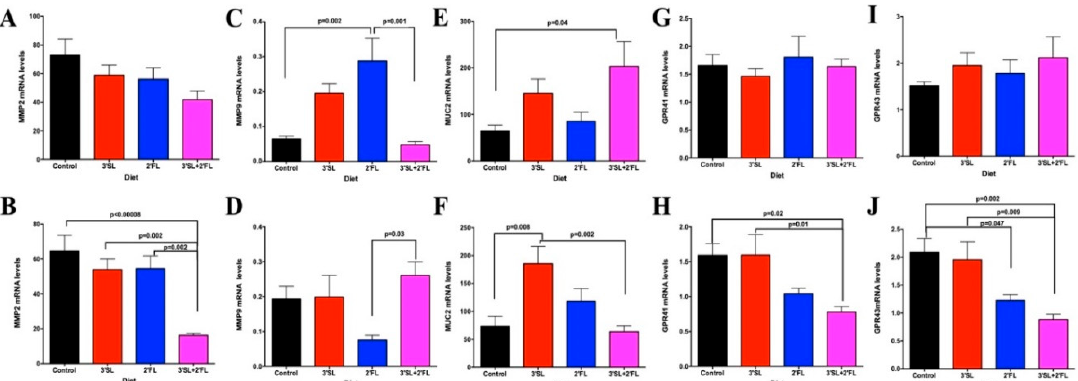
Figure 4. Proximal colon messenger RNA (mRNA) levels of ( A ) matrix metalloproteinase 2 (MMP2), ( C ) MMP9, ( E ) mucin 2 (MUC2) ( G ) G-protein-coupled receptor 41 (GPR41), and ( I ) GPR43 in male and ( B ) MMP2, ( D ) MMP9, ( F ) MUC2, ( H ) GPR41, and ( J ) GPR43 in female rats fed the AIN-93 diet fortified with 3’SL, 2’FL, both, or neither for eight weeks. Values are means ± SEM, n= 8–10. Control: AIN-93; 3’SL: AIN-93 + 3’sialyllactose; 2’FL: AIN-93 + 2’fucosyllactose; 3’SL + 2’FL: AIN-93 +